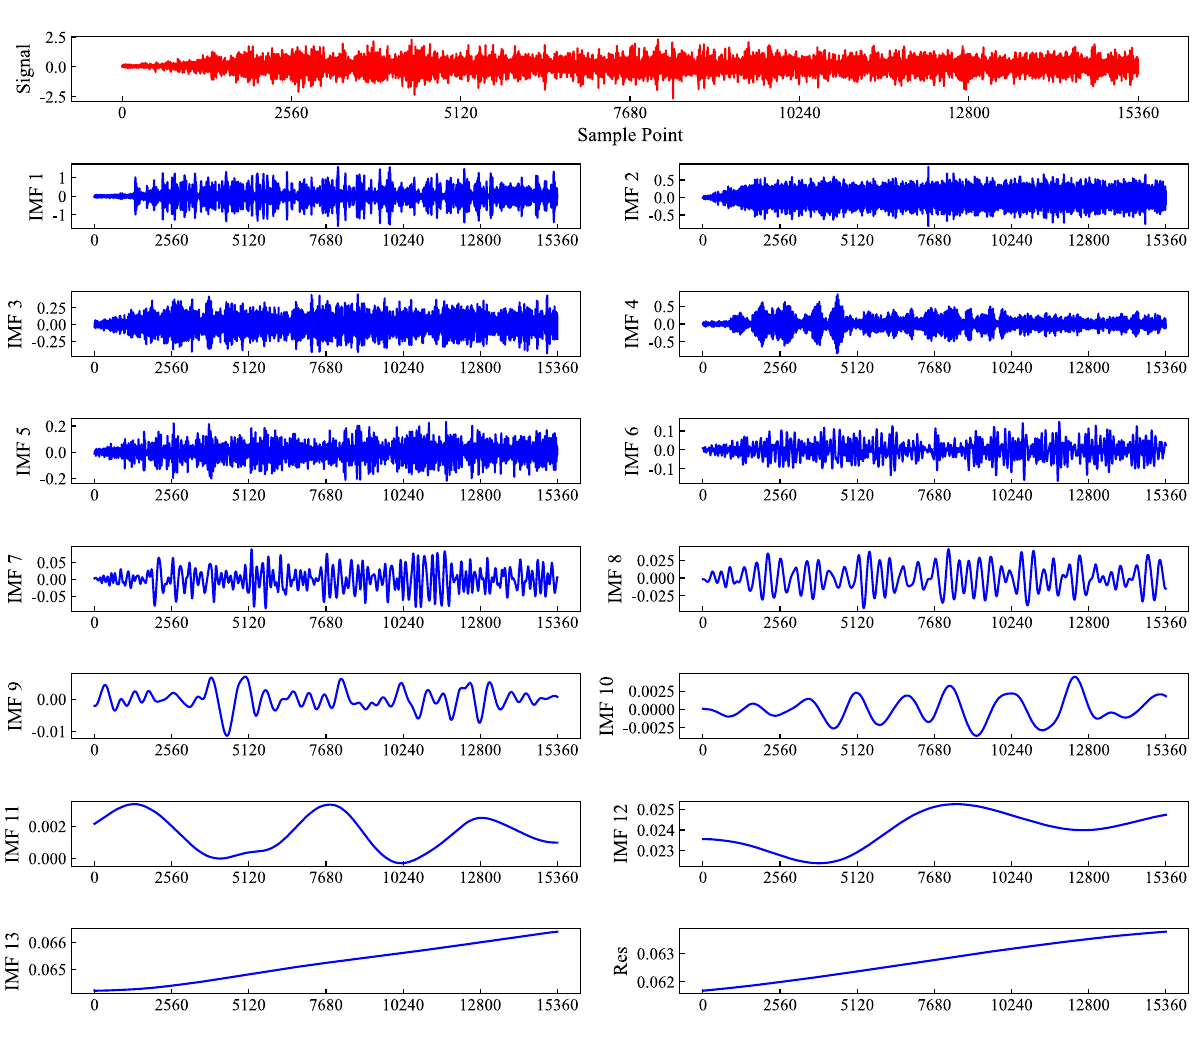
Figure 6. Data input and output of the proposed model.